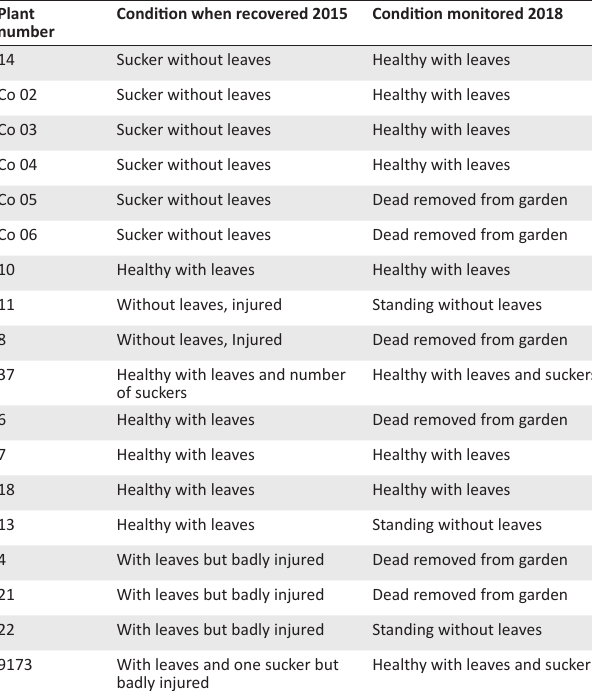
TABLE 2: Monitoring result for planted cycads in gardens of Addo Elephant National Park. Plant number